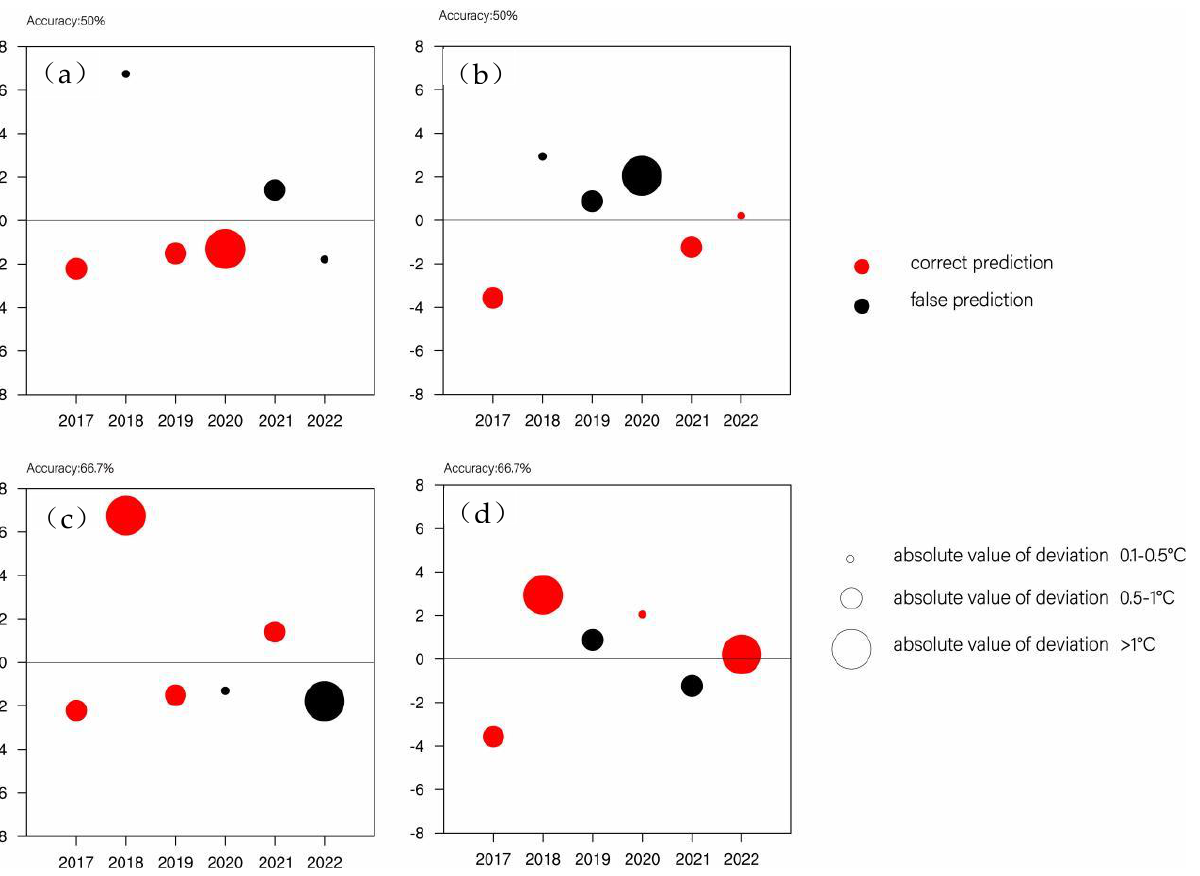
Figure 10. Forecast accuracy of the WPSH ridge line using the ( a , b ) Kuroshio SSTs and ( c , d ) the Nino 1+2 SST. ( a , c ) are for July. ( b , d ) are for August.